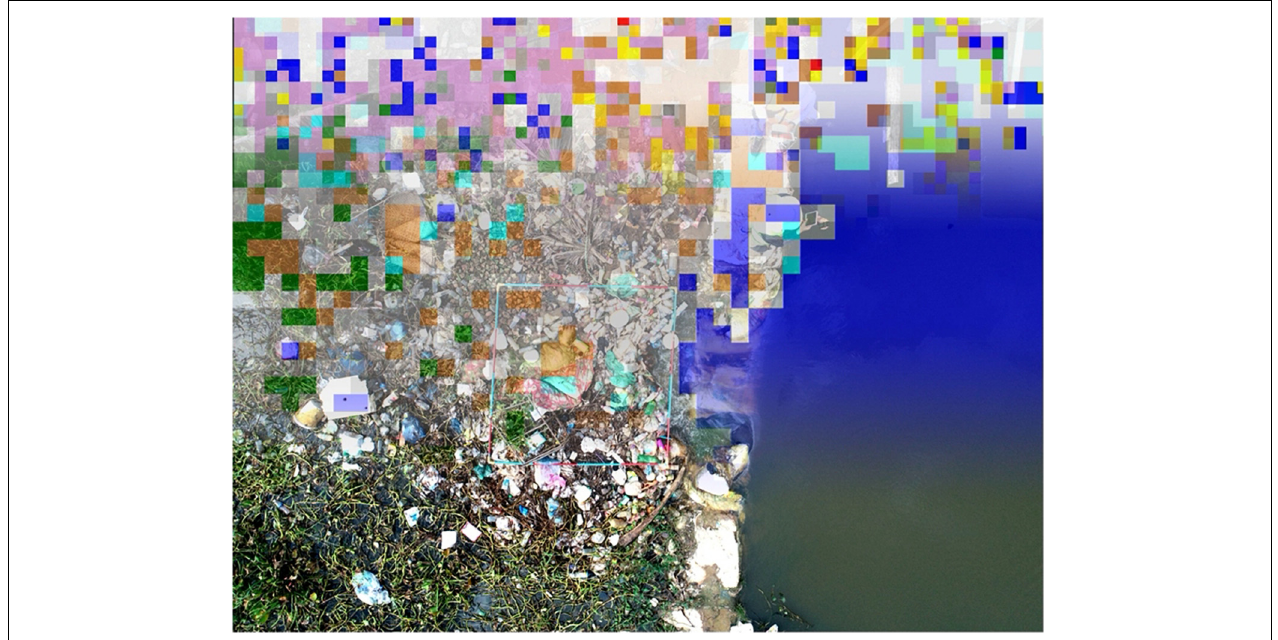
FIGURE 7 | Application of the APlastic algorithm, originally designed for UAV operations over plastic liter, from a citizen smartphone (Courtesy of DFKI-German Research Center for Artificial Intelligence).